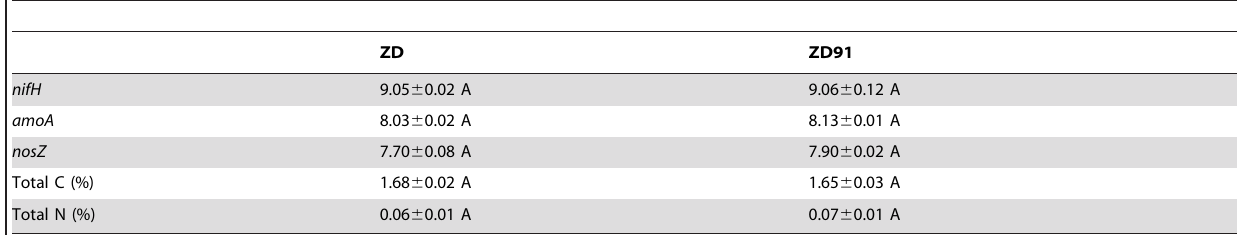
Table 1. Changes in abundance of nifH , amoA , and nosZ genes (Log 10 copies/g soil), and carbon (C), nitrogen (N) contents in rhizosphere soil ( P , 0.01).